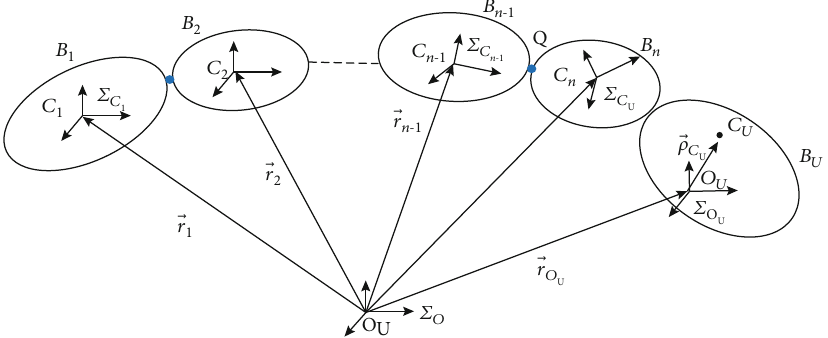
Figure 10: Topology structure of space robot